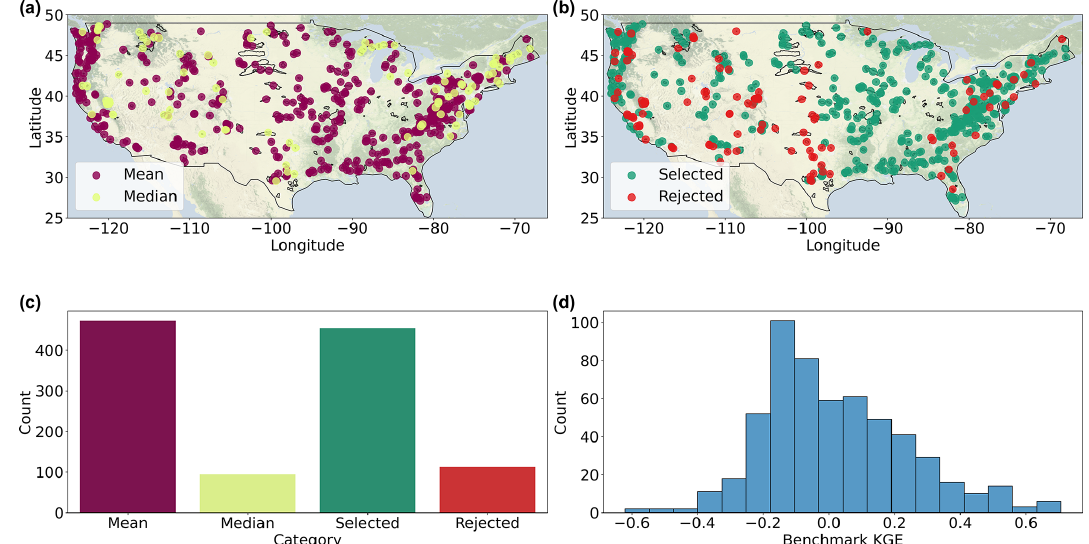
Figure 5. Evaluation period results. (a) The best-performing type of 10-year calendar day climatology, either mean (purple) or median (yellow). (b) The spatial distribution of accepted (green) and rejected (red) basins based on the benchmark. (c) Overview of the amount of basins that are accepted or rejected and the best-performing benchmark type. (d) The 2012 KGE score distribution of the best-performing benchmark type. Basemaps are made with Natural Earth.